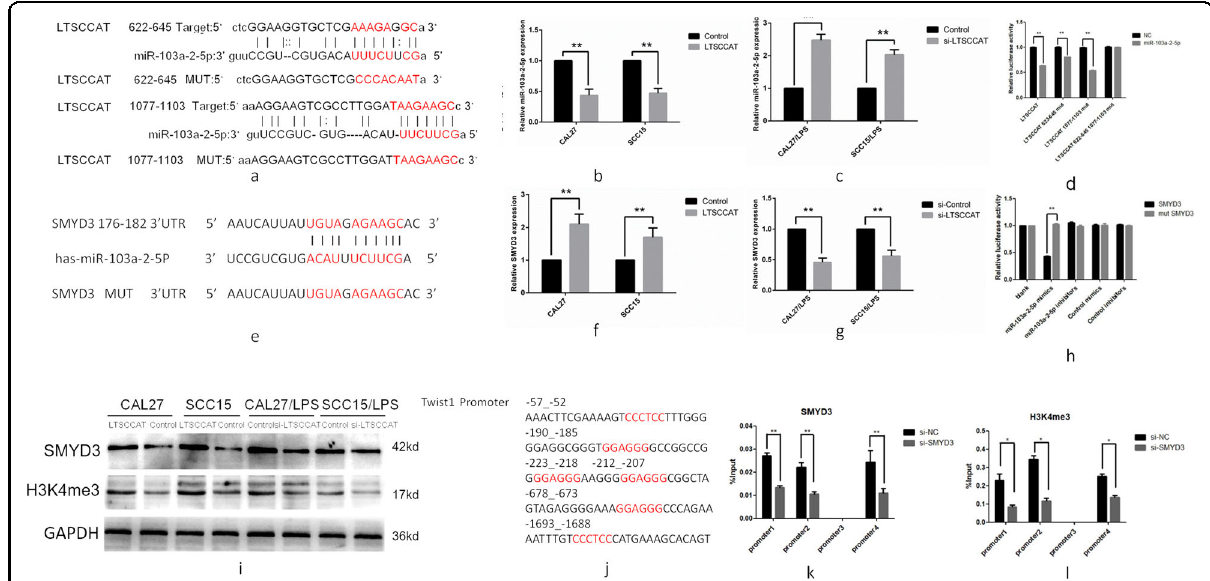
Fig. 5 LTSCCAT promotes invasion and metastasis of TSCC via the miR-103a-2-5p/SMYD3/Twist1 signaling pathway. a Target sequence of LTSCCAT in the miR-103a-2-5p 3 ′ -UTR predicted by RegRNA 2.0 as well as the mutated sequence. b Expression of miR-103a-2-5p was decreased in CAL27 and SCC15 cells overexpressing LTSCCAT. Error bars represent the mean±S.D. from three independent experiments. (** P < 0.01). c miR-103a-2- 5p was downregulated in CAL27/LPS and SCC15/LPS cells after knockdown of LTSCCAT. Error bars represent the mean±S.D. from three independent experiments. (** P < 0.01). d Dual-luciferase reporter assays were performed by cotransfecting miR-103a-2-5p mimics with wild-type and mutant LTSCCAT in 293 T cells, which indicated that miR-103a-2-5p mimics could impair wild-type LTSCCAT promoter transcriptional activity compared with the negative control vector. However, no changes were observed in the mutation group. Error bars represent the mean±S.D. from three independent experiments. (* P < 0.05, ** P < 0.01). e Target sequence of SMYD3 in the miR-103a-2-5p 3 ′ -UTR, as well as the mutated sequence, was predicted by RegRNA 2.0. f SMYD3 was upregulated in CAL27 and SCC15 cells overexpressing LTSCCAT. Error bars represent the mean±S.D. from three independent experiments. (** P < 0.01). g SMYD3 was downregulated after knockdown of LTSCCAT in CAL27/LPS and SCC15/LPS cells. Error bars represent the mean±S.D. from three independent experiments. (** P < 0.01). h Western blot analysis showed that SMYD3 and H3K4me3 were upregulated after overexpression of LTSCCAT in CAL27 and SCC15 cells, and SMYD3 and H3K4me3 were downregulated after knockdown of LTSCCAT in CAL27/LPS and SCC15/LPS cells. i Wild-type SMYD3 and mutant SMYD3 were cloned into the luciferase plasmid and cotransfected with mimics and inhibitors of miR-103a-2-5p. The R/F ratio of miR-103a-2-5p mimics cotransfected with wild-type SMYD3 was signi fi cantly lower than that of the blank group and the mutant group, indicating that miR-103a-2-5p can interact with wild-type SMYD3. Error bars represent the mean±S.D. from three independent experiments. (** P < 0.01). j The Twist1 promoter contains four latent binding sites with SMYD3. k , l ChIP assays were performed with the SMYD3 antibody and H3K4me3 antibody, respectively, and puri fi ed DNA was analyzed by QPCR. The results con fi rmed that SMYD3 binds directly to Twist1 and promotes its transcription, which is associated with elevated levels of trimethylation of H3K4. Error bars represent the mean±S. D. from three independent experiments. (* P < 0.05, ** P <